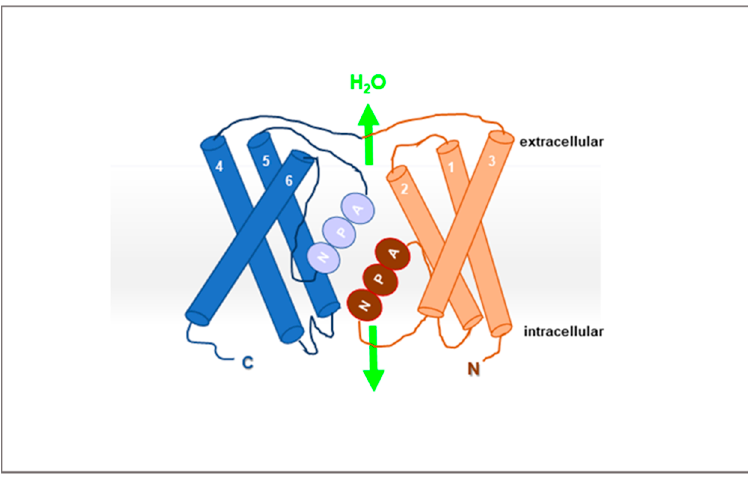
Figure 1. Schematic representation of the Asn-Pro-Ala (NPA) motif in the aquaporin (AQP) structure. Table 1. Classification and permeability characteristics of AQPs.